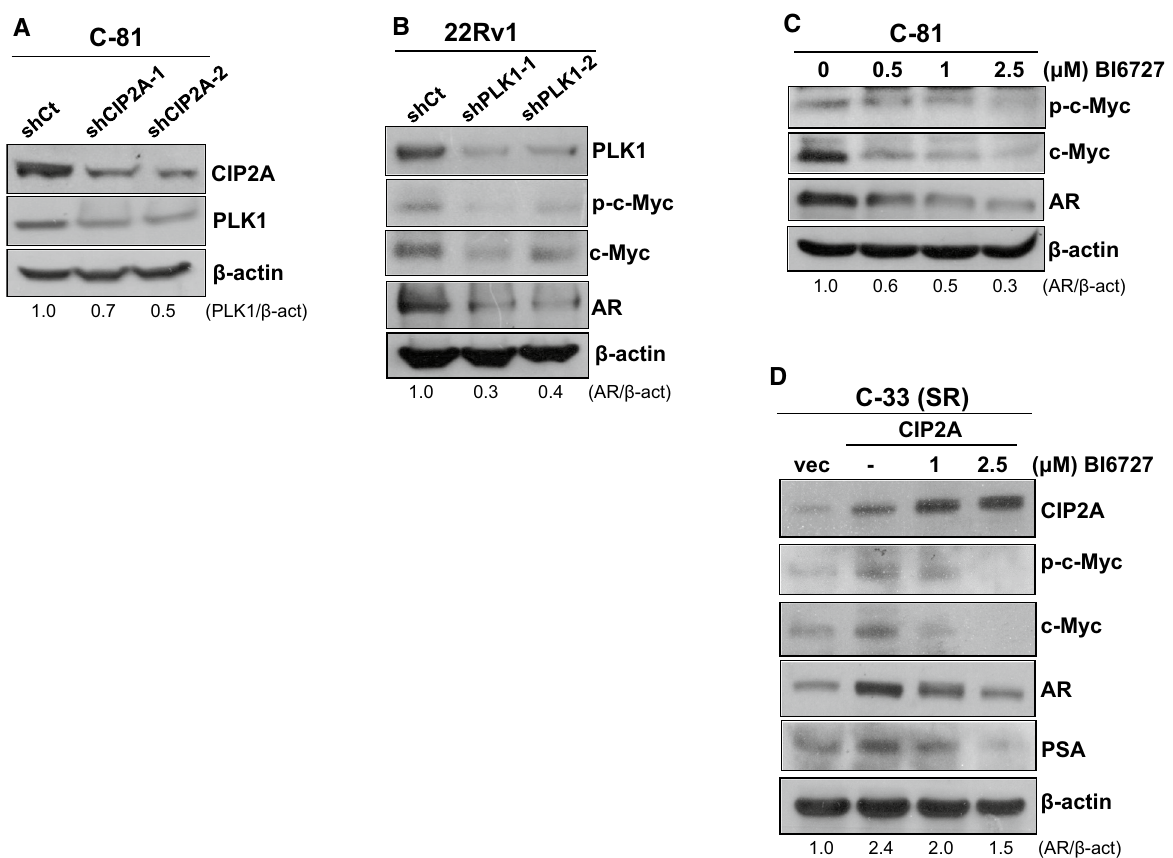
Fig. 5 Effects of PLK1 expression or activity on the CIP2A-regulated AR protein level. A The total lysates from the shCt control and CIP2A- knockdown C-81 cells were prepared for western blot analyses. B 22Rv1 cells infected with viruses carrying the LacZ -targeted shRNA (shCt) or PLK1 -targeted shRNAs (shPLK1-1 or shPLK1-2) were harvested for western blot analyses. C C-81 cells were treated with 0.5 μM, 1 μM, or 2.5 μM of BI6727. Cells treated with an equal volume of solvent (DMSO) served as the control. After 24 h of incubation, the cell lysates